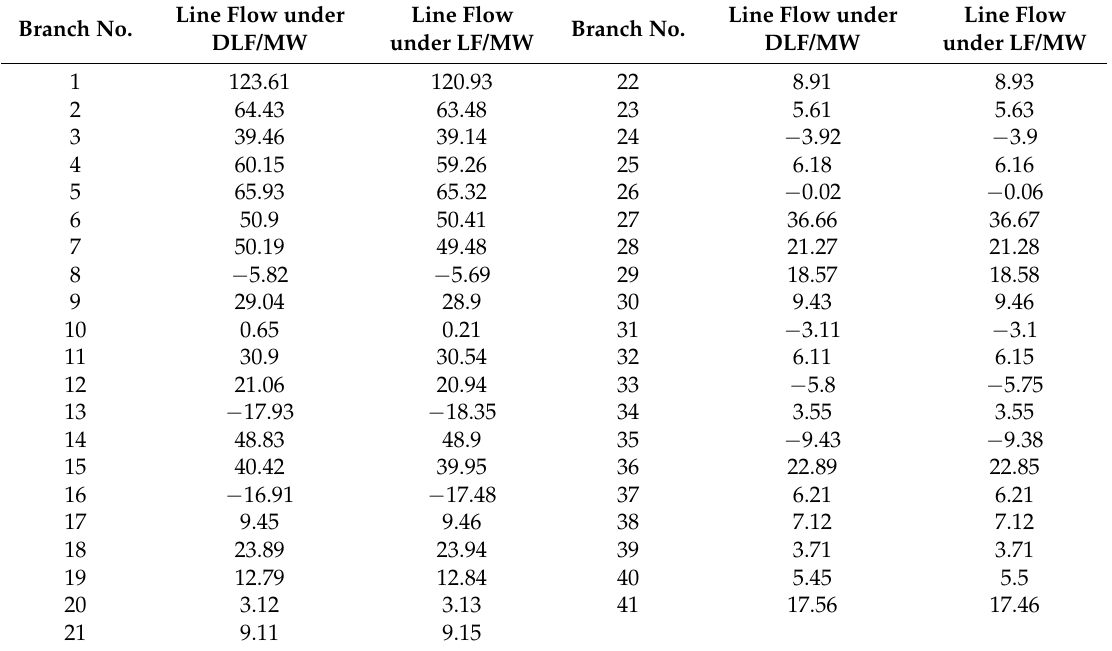
Table 4. Line flow under DLF and